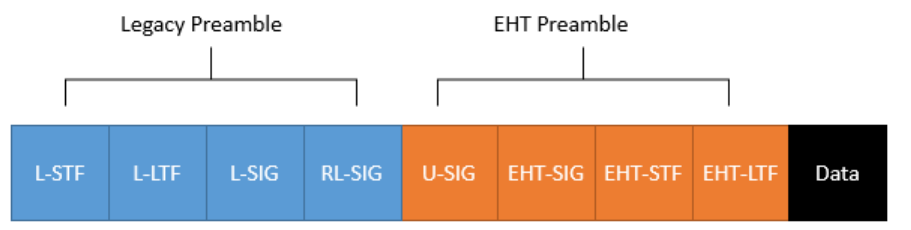
Figure 1. IEEE 802.11be PPDU